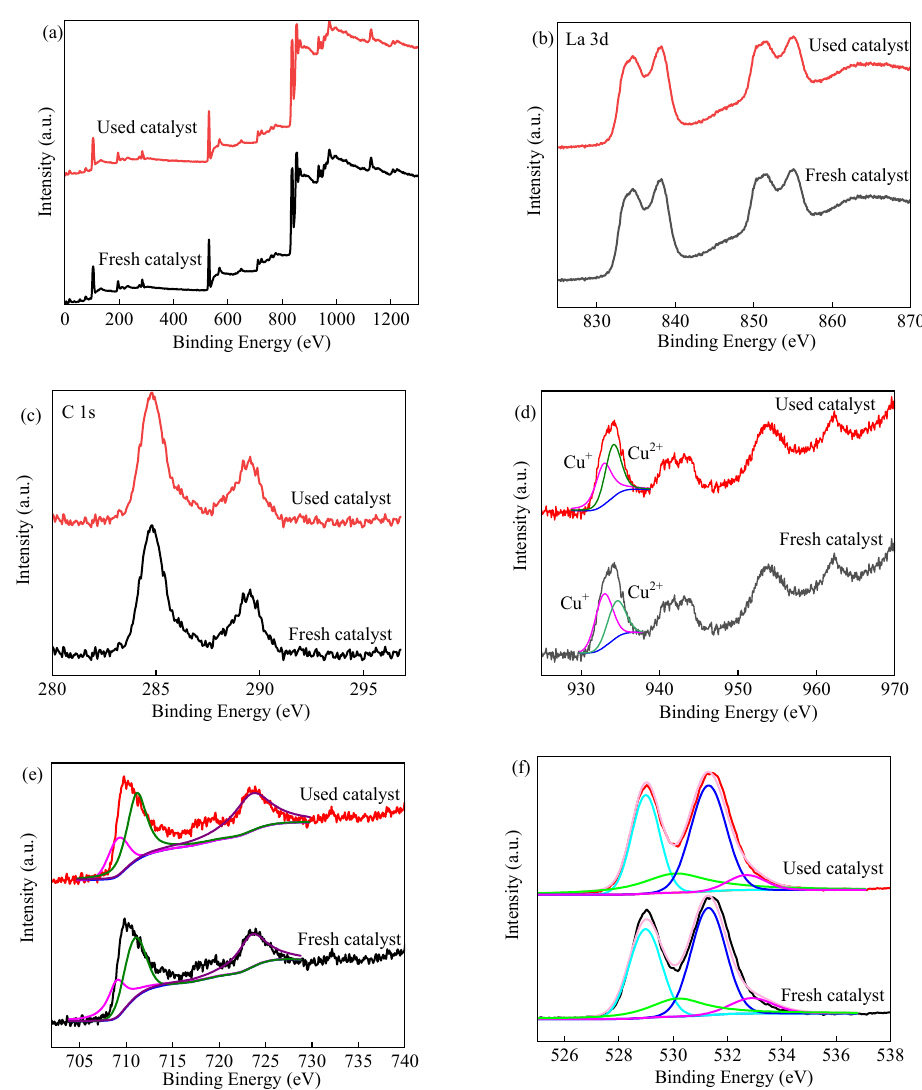
Figure 3. The deconvoluted XPS spectra of fresh and used LCFO-4: ( a ) survey spectra; ( b ) La 3d; ( c ) C 1s; ( d ) Cu 2p; ( e ) Fe 2p; ( f ) O